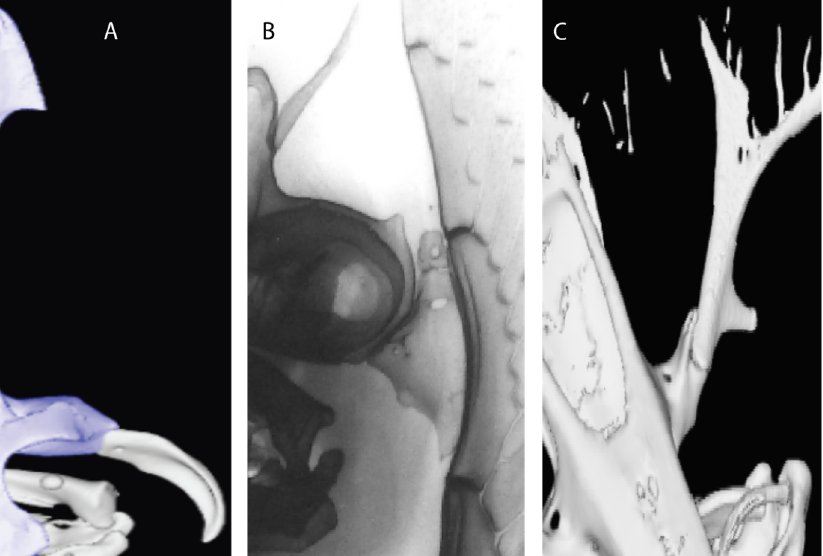
Figure 16. Portion or the neurocranium and antorbital cartilages. State (0): ( A ) Aptychotrema